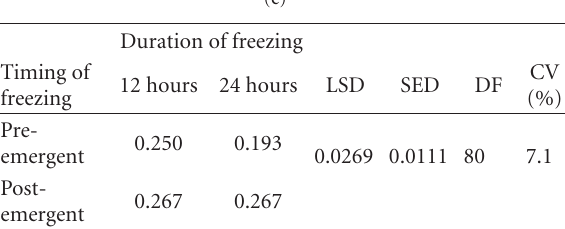
Data are back transformed, statistical analysis performed on square root transformed